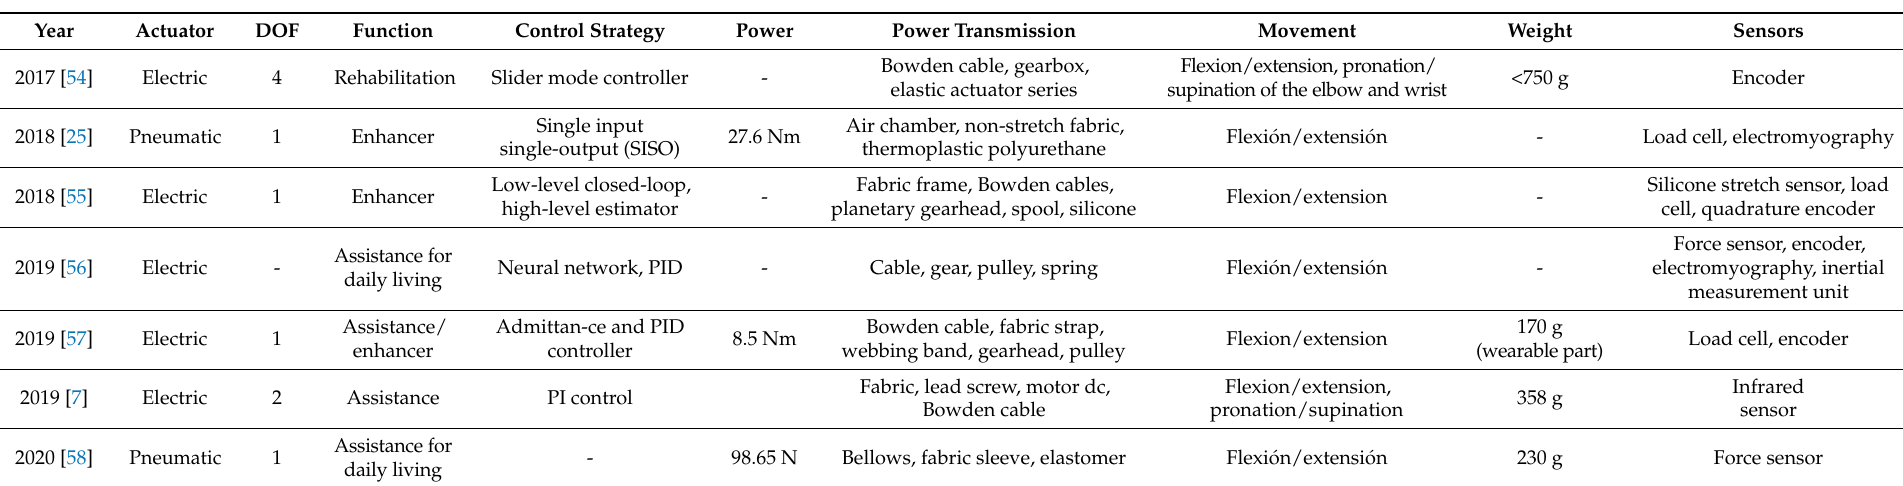
Table 2. Development of soft exoskeletons for the